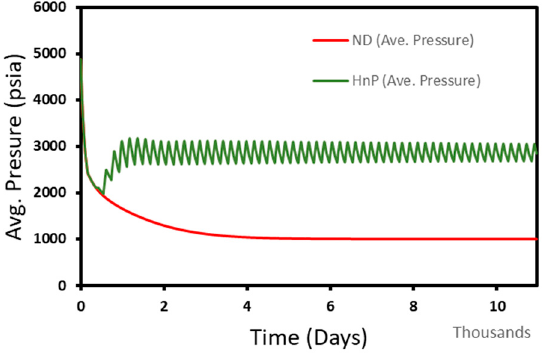
Figure 6. Average pressure over time. ND: Natural depletion; HnP: huff-n-puff.